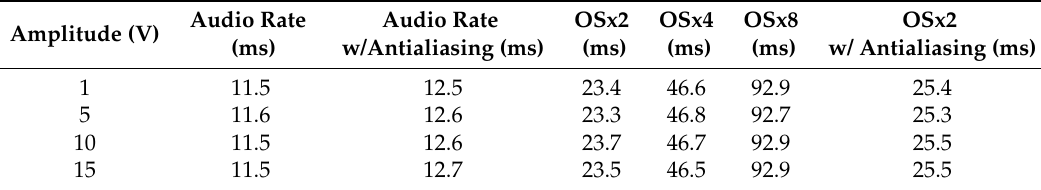
Table 5. Averaged computation times (in milliseconds) for the proposed Lockhart wavefolder model ( R L = 50k Ω ) implemented in C for a 1-s 100-Hz sinusoidal input sampled at different oversampling (OS) rates and with different peak amplitude levels.